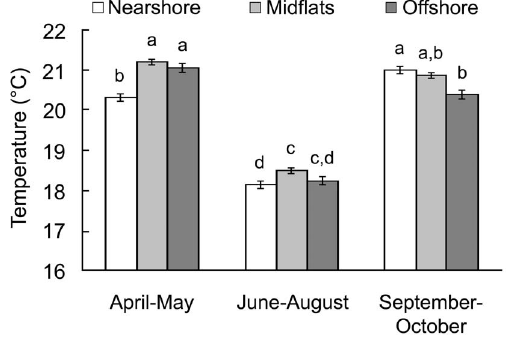
Figure 3. Sandflat temperatures. Seasonal temperatures (mean 6- standard error) per microhabitat for the time period between 23 April 2007 and 14 October 2007. Bars with different letters are significantly different at P , 0.01.